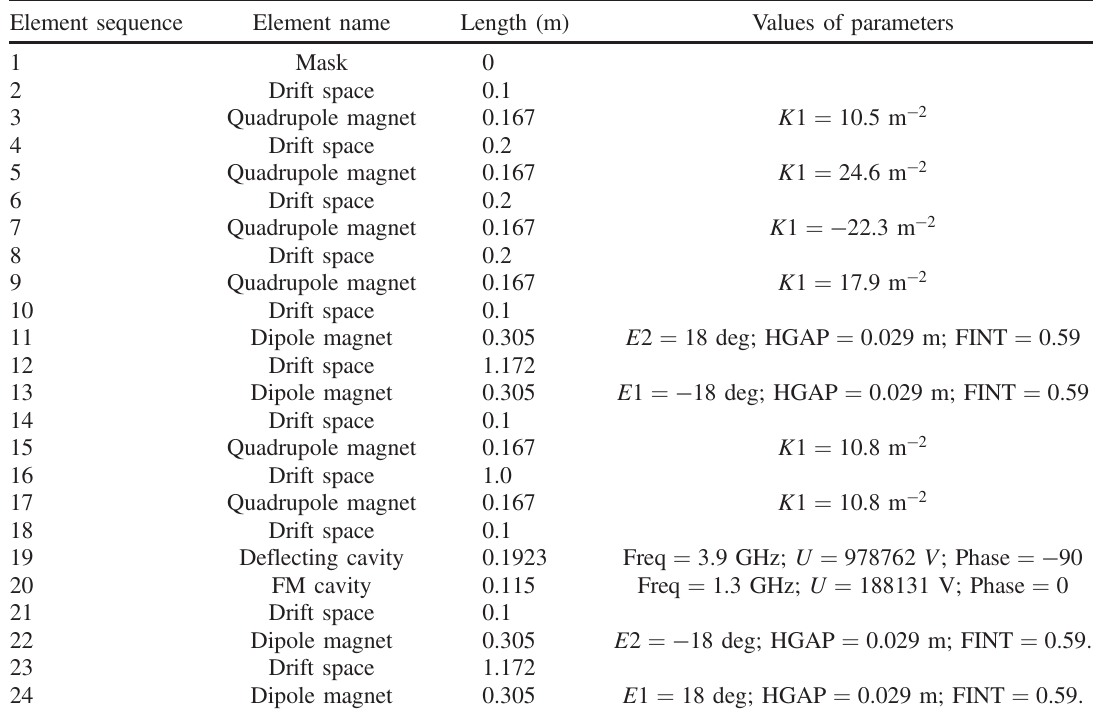
TABLE III. Optimized parameters of the chicane type EEX. Element